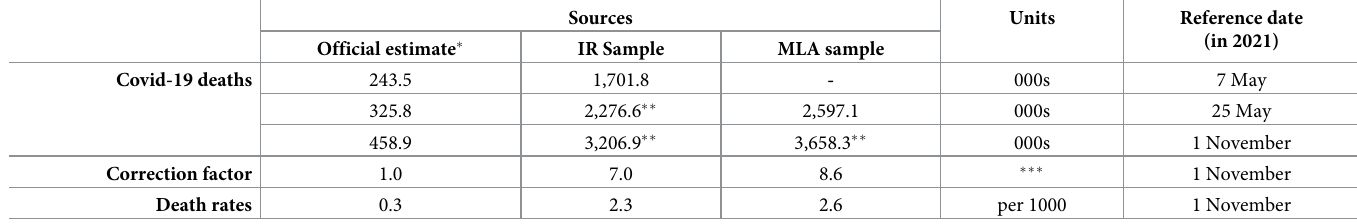
Table 1. Estimates of cumulative Covid-19 deaths in